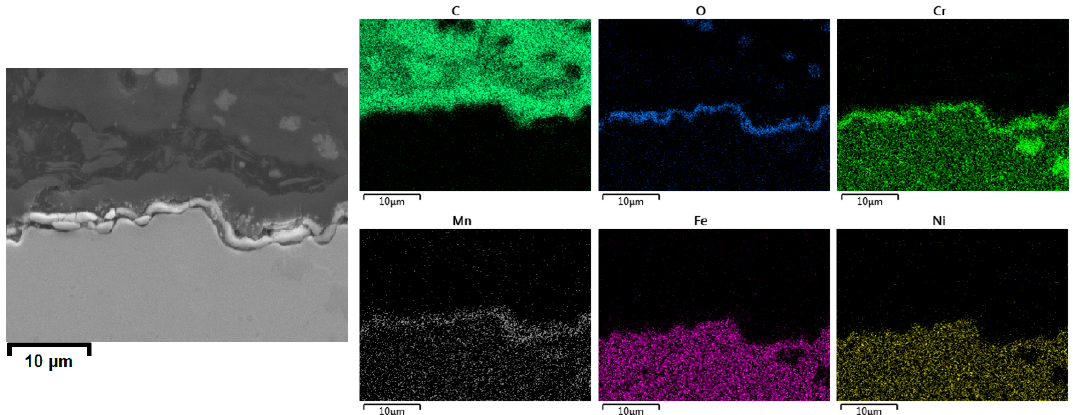
Figure 11. SEM and EDX cross-sectional elemental mappings of the coked Cr–Ni–Fe reference alloy after pretreatment A and seven coking/decoking cycles followed by a 6 h coking. Accelerating Voltage: 15 kV.